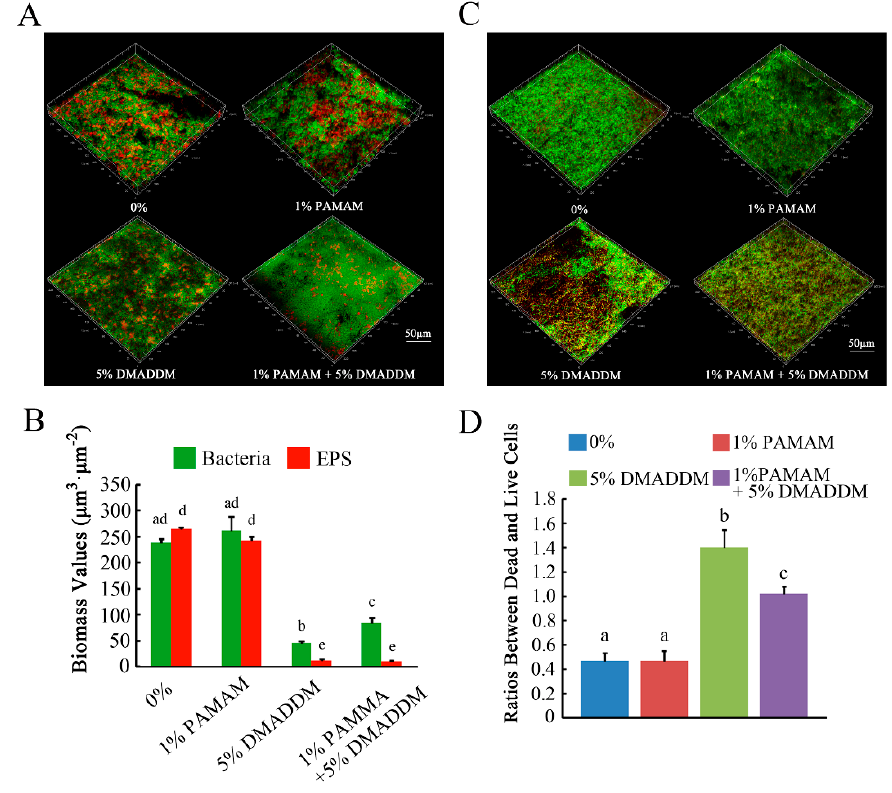
Figure 4. The micrographs of exopolysaccharide (EPS) staining and live/dead staining. ( A ) EPS staining of biofilms on the cured disks of the four groups. Bacteria were stained green , and EPS were stained red ; ( B ) partly quantified analysis of bacteria and EPS production; ( C ) live/dead staining of biofilms on the cured disks of the four groups. Live cells were stained green , and dead cells were stained red ; ( D ) Ratios between dead and live cells for four groups. Results were averaged from three randomly selected views of each group and are presented as mean ± standard deviation. Bars with the same letter indicate values that have no significant difference ( p > 0.1) and those with the dissimilar letters indicate significant difference ( p < 0.05).